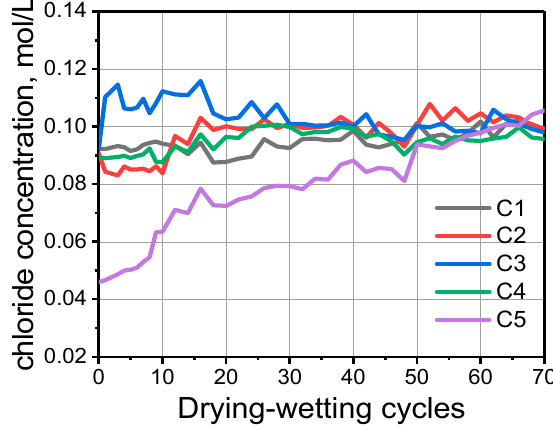
Figure 8. Chloride concentration calculated by Nernst’s law with presence of temperature correction.